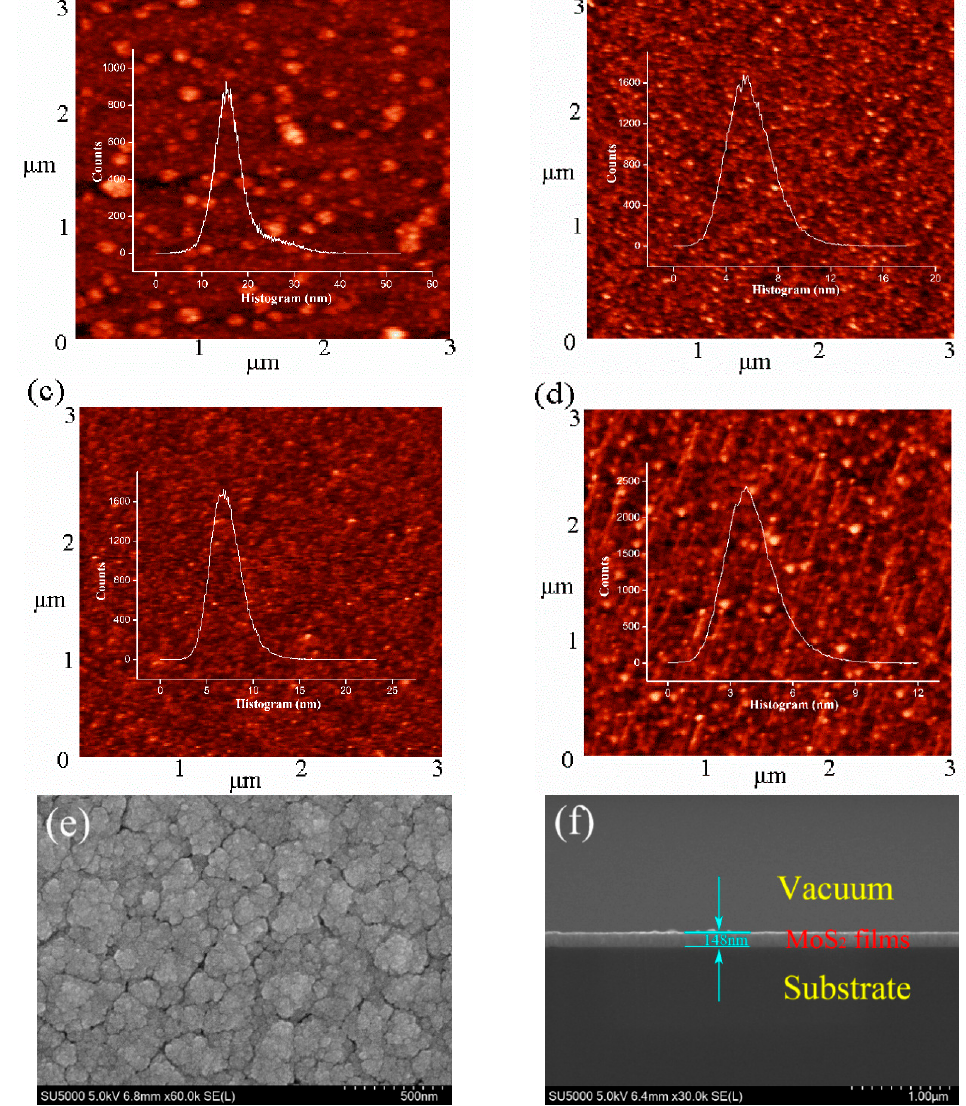
Figure 2. Two-dimensional (2D) atomic force microscopy (AFM) images of the MoS 2 films at ( a ) 0.8 Pa, ( b ) 1.0 Pa, ( c ) 1.2 Pa, and ( d ) 1.4 Pa. SEM images of the MoS 2 films at 1.0 Pa: ( e ) surface morphology and ( f )